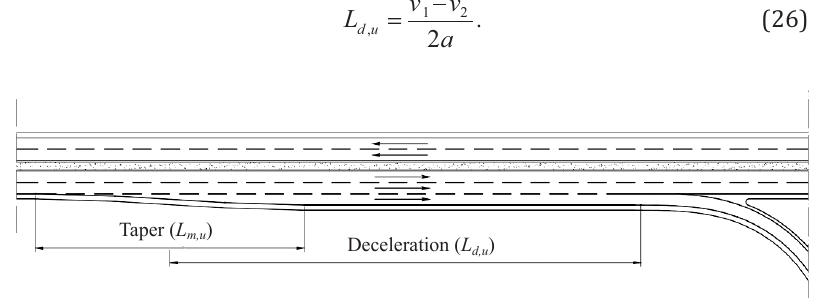
Deceleration ( L d,u